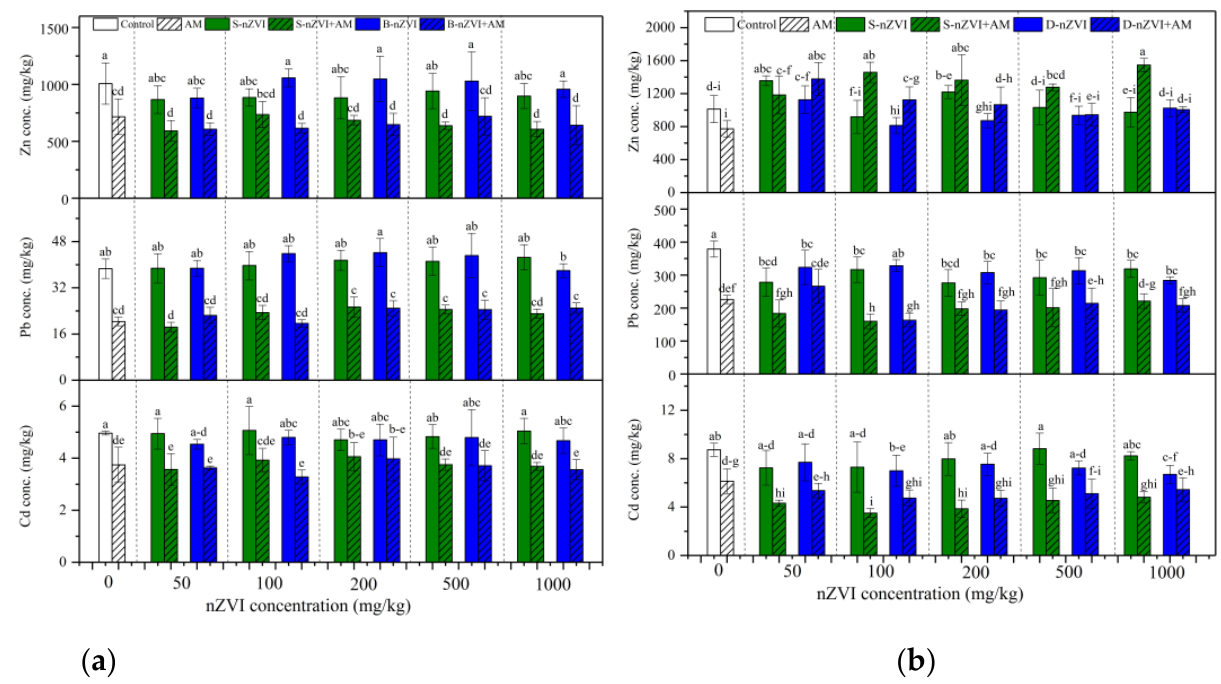
Figure 4. Concentrations of Cd, Pb and Zn in plant shoots ( a ) and roots ( b ). Control represents the treatment without AM inoculation or nZVI; AM represents the treatments inoculated with A. mellea ZZ; S-nZVI represents the treatments that received S-nZVI; S-nZVI+AM represents the treatments that received S-nZVI and AM inoculation; B-nZVI the treatments that received B-nZVI; B-nZVI+AM represents the treatments that received B-nZVI and AM inoculation. Different letters above the bars indicate significant differences ( p < 0.05). Three-way and two-way ANOVA results are shown in Tables 2 and 3, respectively.